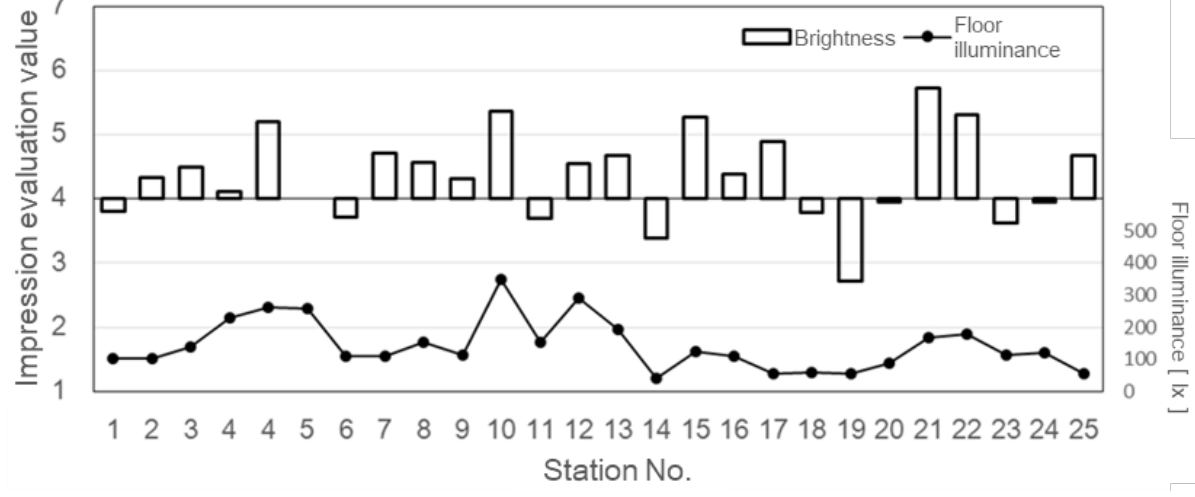
Figure 9. Results of impression evaluation of brightness and floor illuminance.